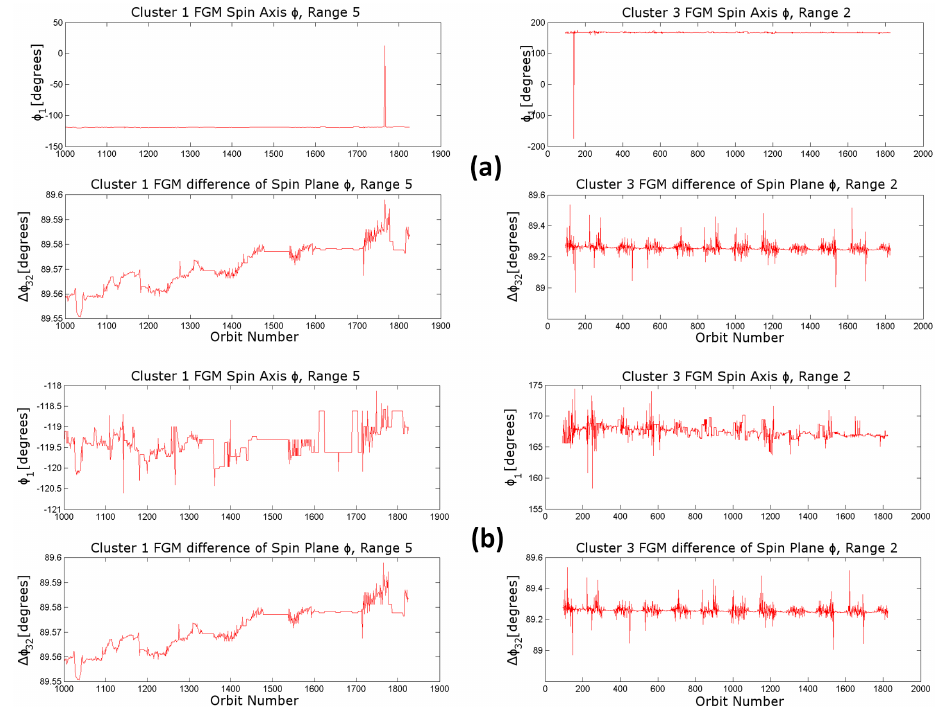
Figure 14. Azimuthal angles, ϕ 1 and 1ϕ 32 , for C1, range 5 and C3, range 2. The top four plots show the angles before the unphysical calibration parameters were corrected and the lower four plots show them after